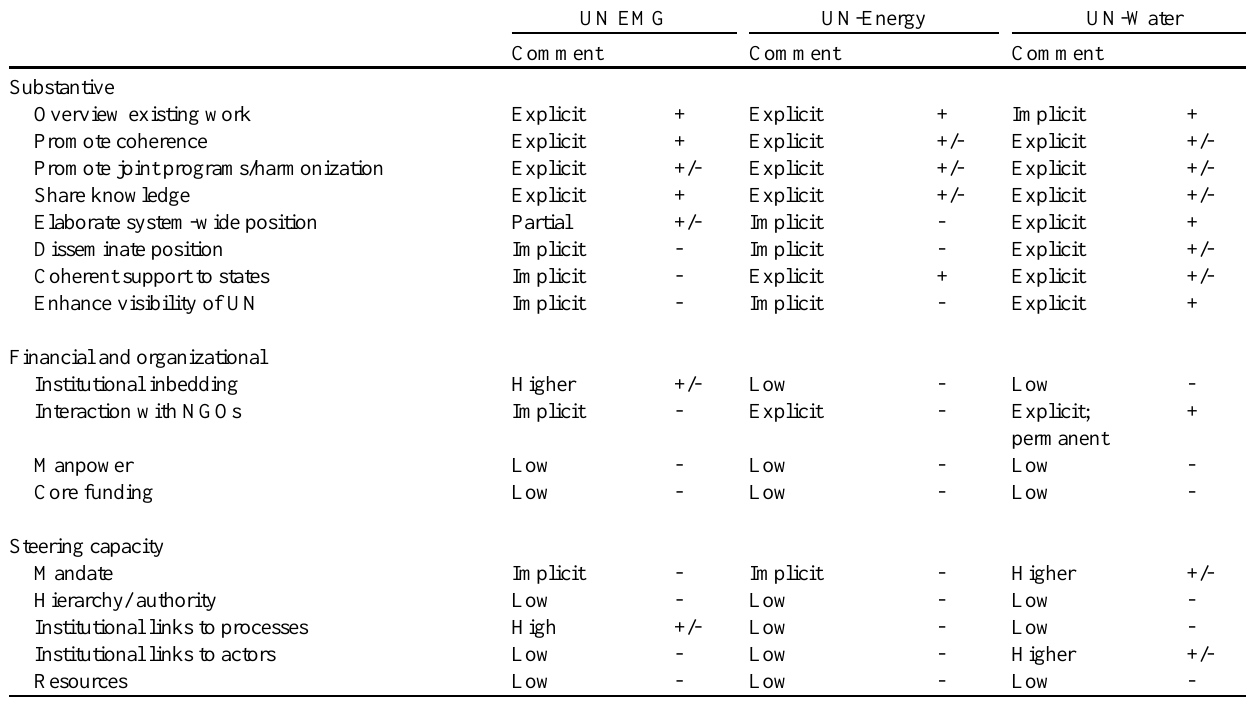
Table 1 . Assessing the three